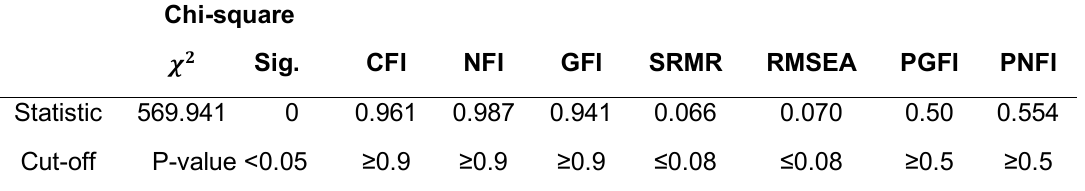
Table 3: Model Fitness Tests